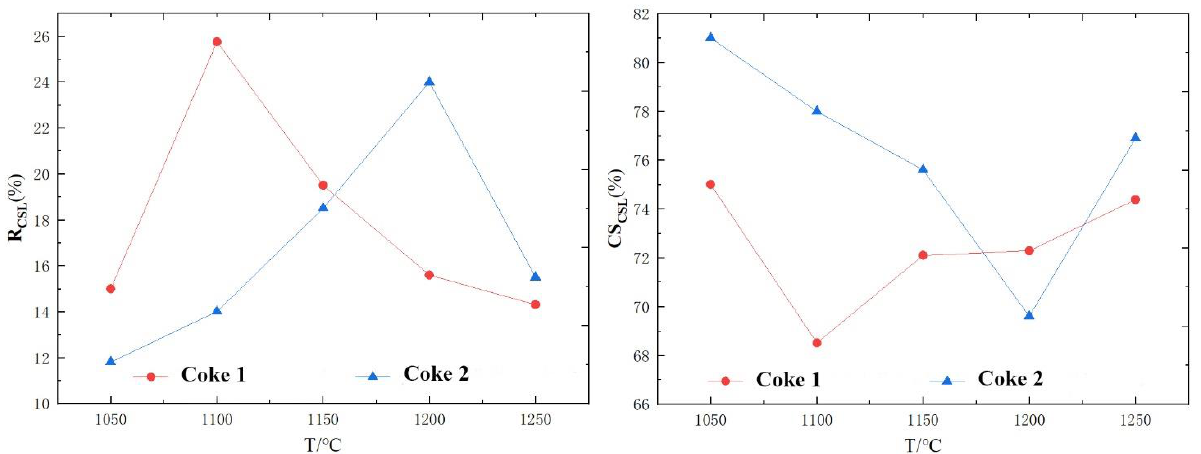
Figure 8. R CSL and CS CSL of coke at various temperatures.